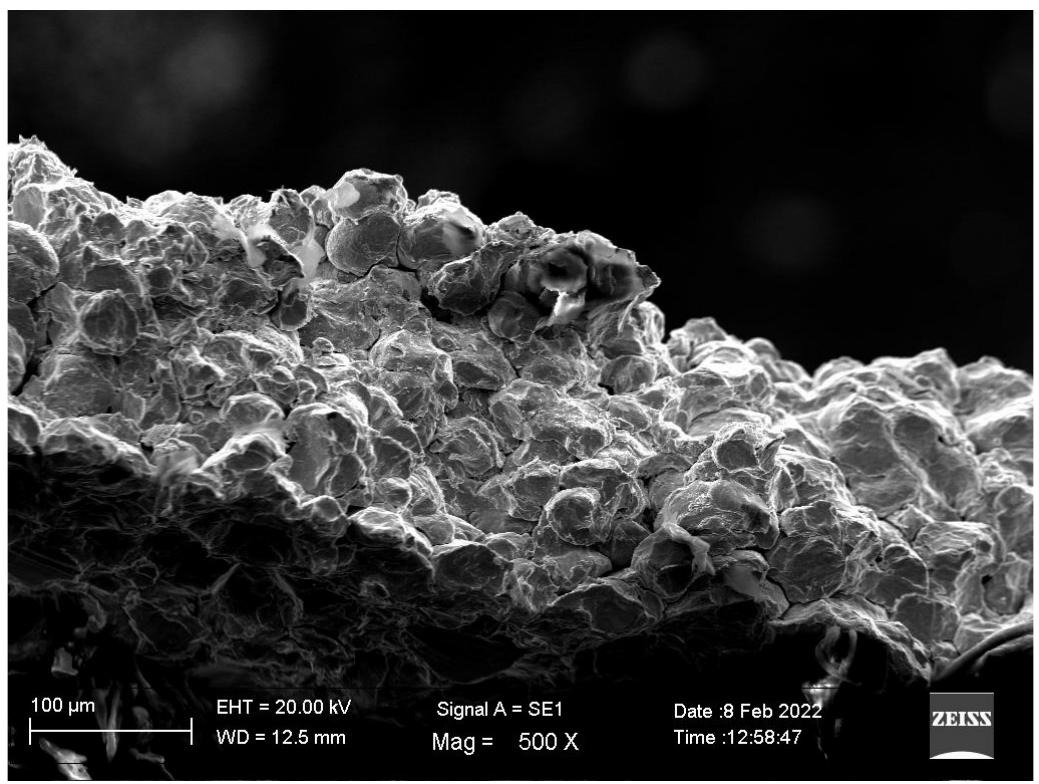
Figure 13. Fracture surface of the notched sample tested at the maximum stroke of 1.2 mm.